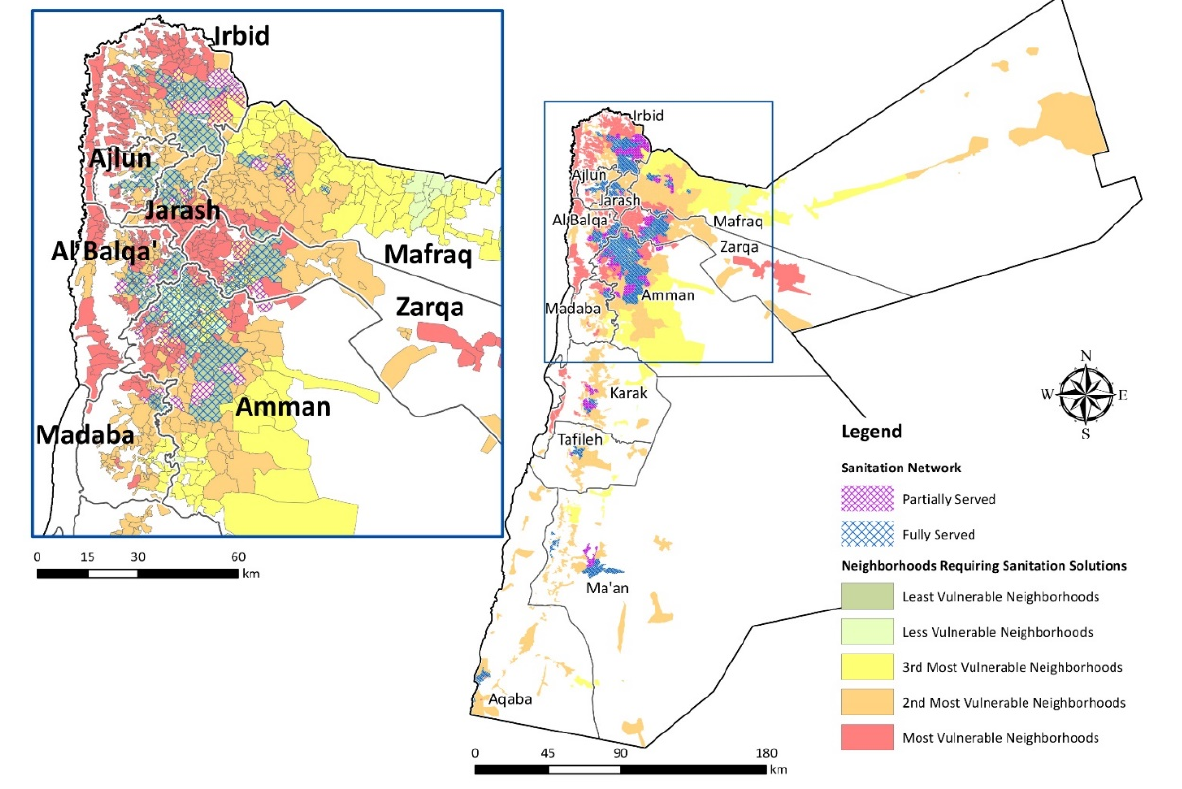
Figure 12. Neighborhoods-scale Sanitation Hotspot Map. Table 6. Most Vulnerable Districts in